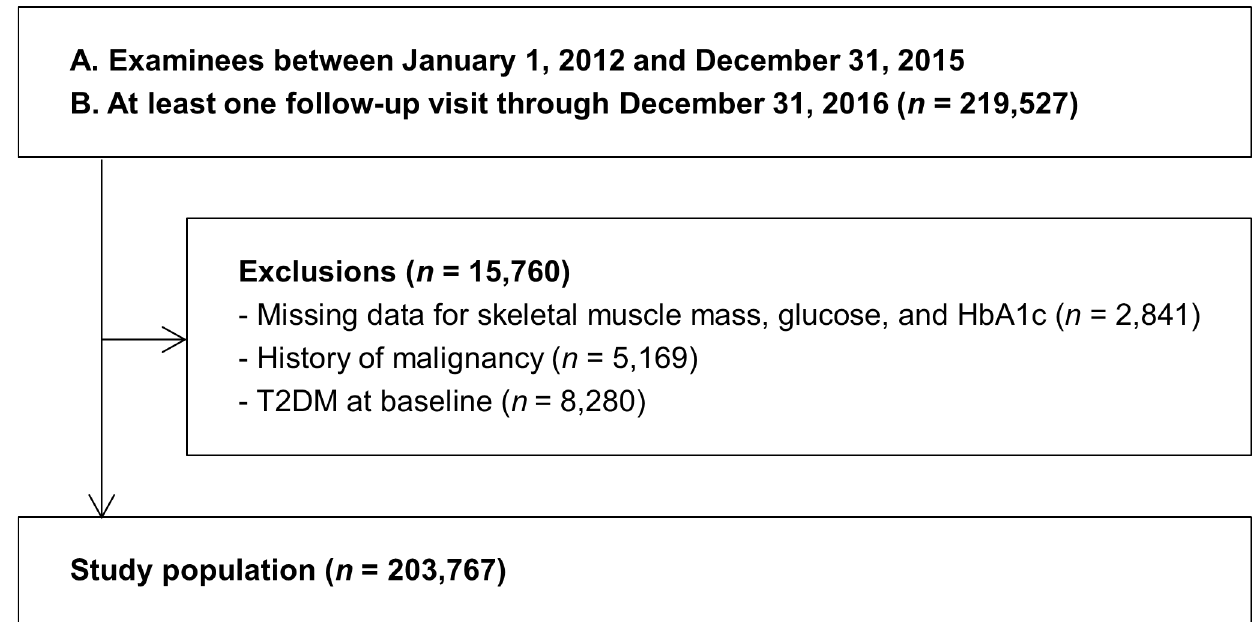
Fig 1. Selection of study population. Of the peoplewho were examinedbetweenJanuary1, 2012 and December 31, 2014, 219,527people had at least one follow-upvisit by December 31, 2016, and 203,767were eventually includedin the study. T2DM, type 2 diabetesmellitus.